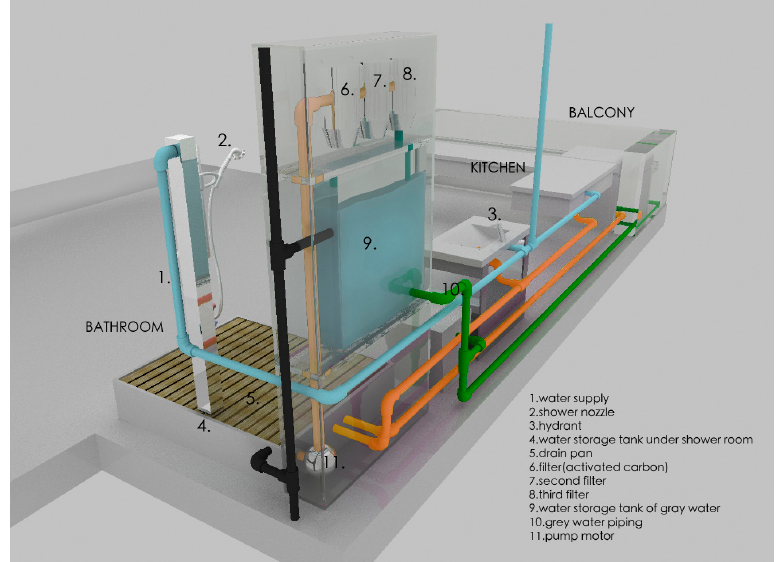
Figure 5. ICGS design introduced to the case.